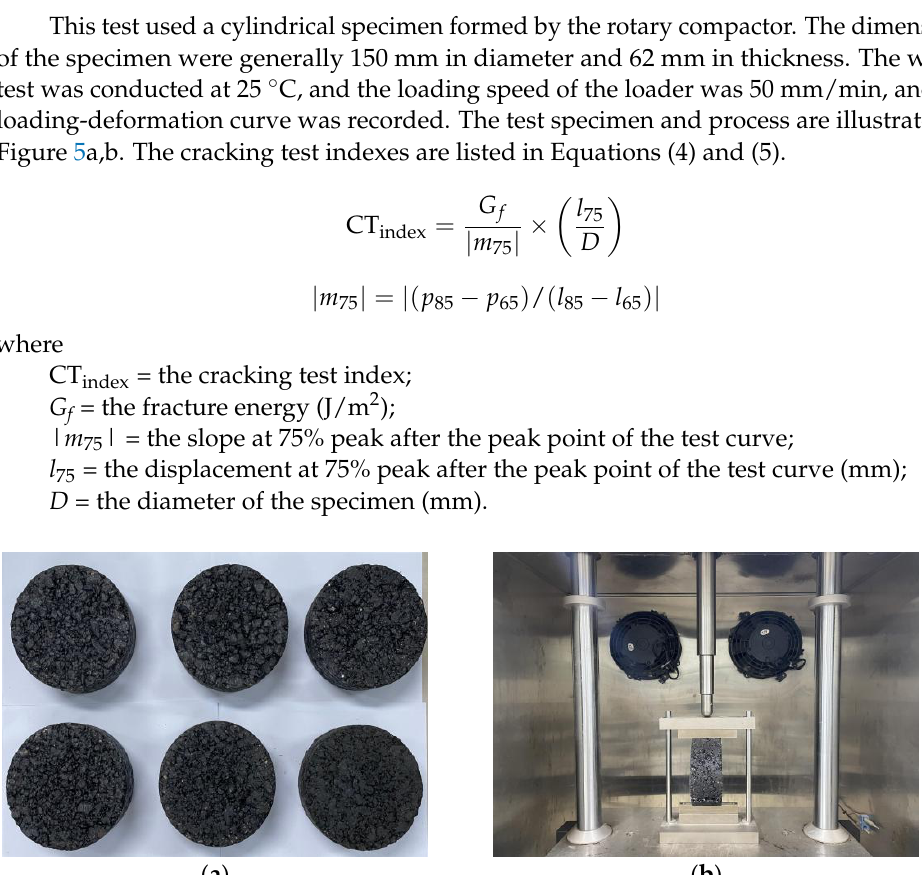
Figure 5. IDEAL cracking test: ( a ) forming trabecular specimen; ( b ) test photo.